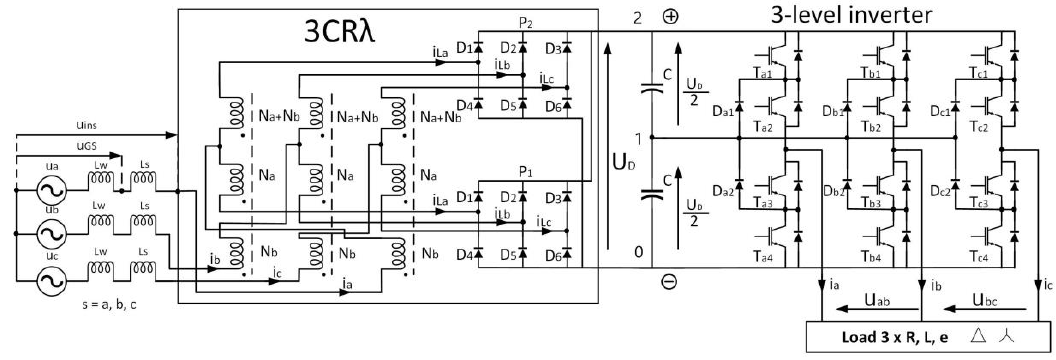
Figure 3. Schematic diagram of the considered rectifier supplying a three-level inverter.